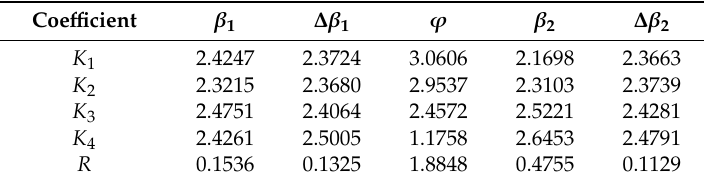
Table 8. Range analysis of multiobjective